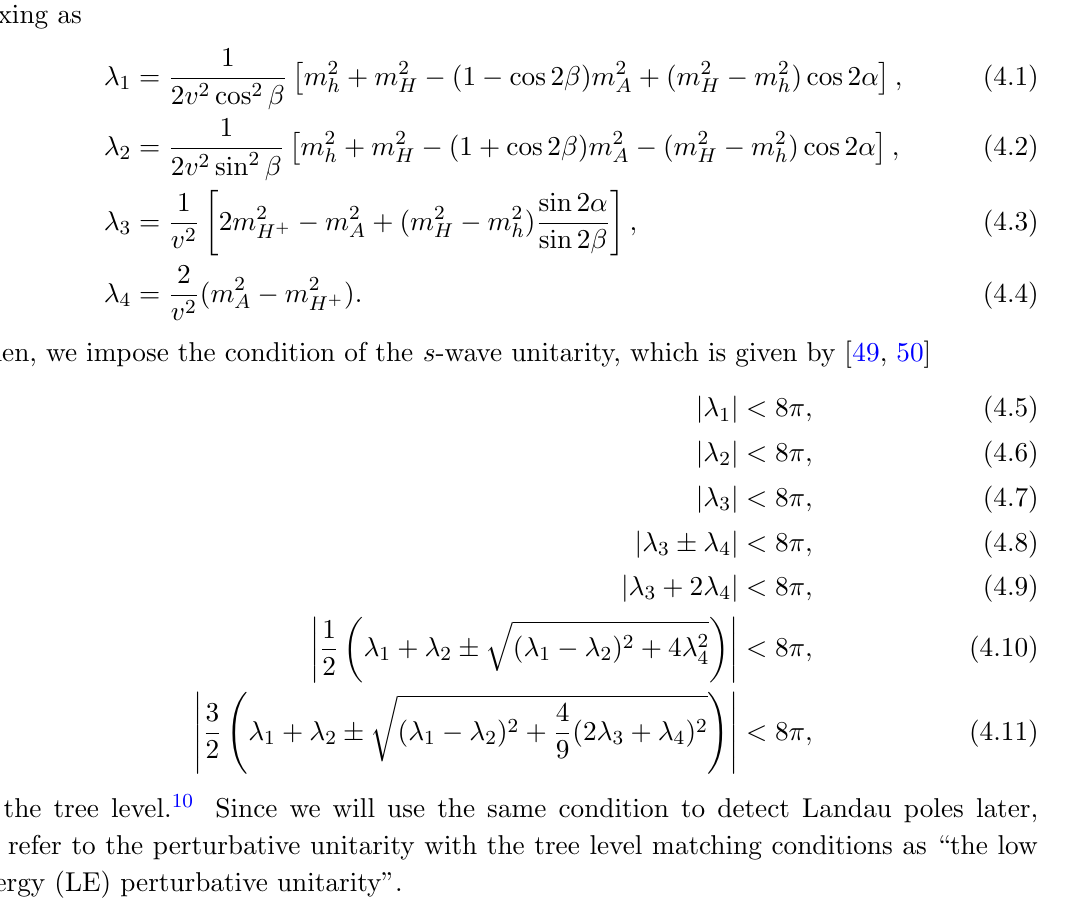
, BR( B s ! (cid:22)(cid:22) ), and BR( B ! (cid:28)(cid:23) ), s